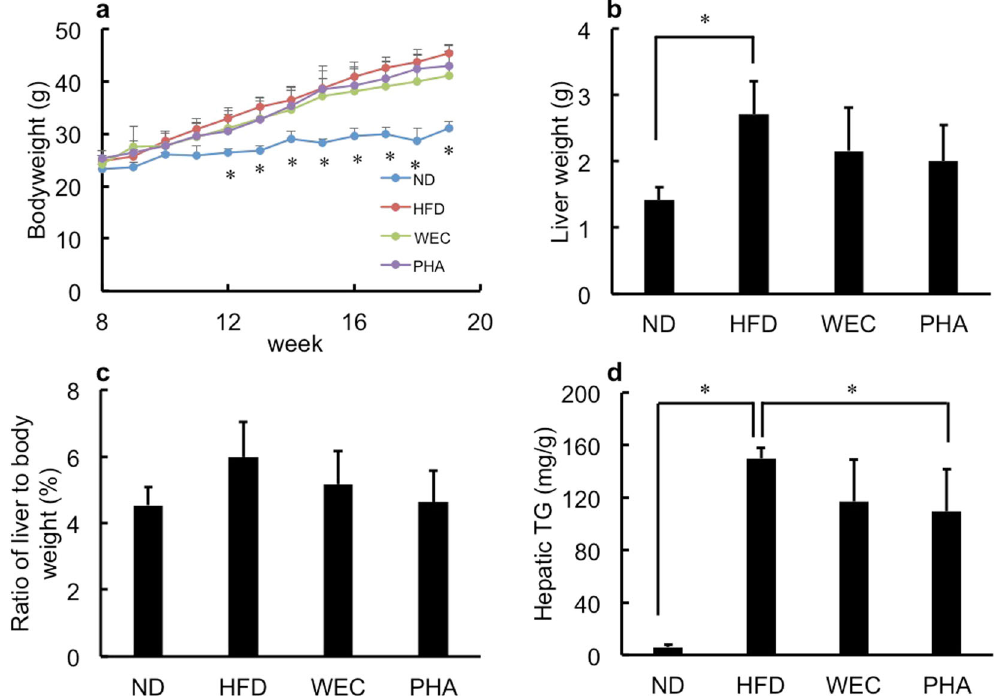
Fig. 1 The effects of WEC and PHA on bodyweight and liver wight. Bodyweight change ( a ), liver weight ( b ), ratio of liver weight to bodyweight ( c ), and hepatic triglyceride levels ( d ) in the normal diet-fed (ND), high-fat diet-fed (HFD), Chlorella pyrenoidosa water extract- treated (WEC), and phenethylamine-treated (PHA) groups. The WEC and PHA groups were fed on HFD and administered with WEC (100 mg/kg bodyweight) and PHA (10 μ g/kg bodyweight), respectively. Data are represented as mean ± standard deviation ( n = 6). The means were compared using analysis of variance, followed by Dunnett ’ s test. * p < 0.05 vs. HFD